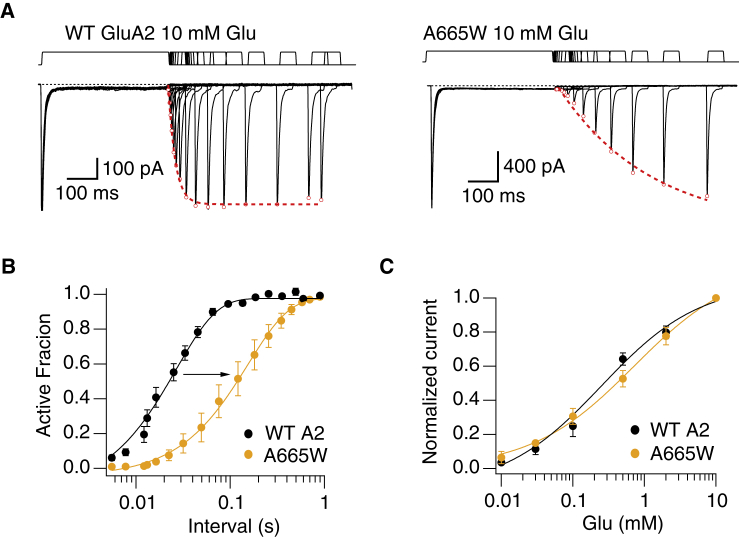
The A665W mutation slows down recovery from desensitization. (A) Currents evoked by 10 mM glutamate from WT GluA2 (left panel) and the mutant A665W (right panel). The two-pulse protocol had a conditioning pulse of 400 ms, followed by a second pulse at increasing intervals (responses are overlaid). Peak currents (red open circles) were fit with Hodgkin-Huxley functions (dashed red lines). (B) Mean of recovery from desensitization for GluA2 WT (black) and A665W (orange). For each interval, the peak of the second pulse is plotted as the AF (relative to the first peak) and fit with a Hodgkin-Huxley equation (with slope fixed to 2, see Materials and Methods). The time constants of recovery from desensitization were 20 ± 2 and 155 ± 5 ms for GluA2 WT and A665W, respectively (probability of no difference = 0.01, Student’s t-test; n = 4). (C) Concentration-response curves for WT GluA2 (blue circles; EC50 = 330 ± 100 μM) and GluA2 A665W (yellow circles; EC50 = 510 ± 130 μM). The probability of no difference between the EC50 values was 0.19 (n = 3 cells). To see this figure in color, go online.